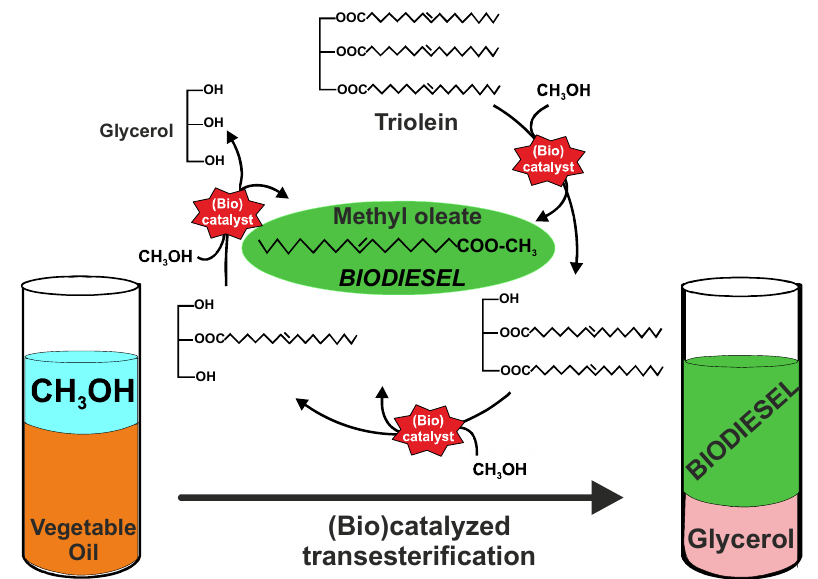
Figure 1. Scheme of the catalyzed transesterification of triglycerides to synthesize